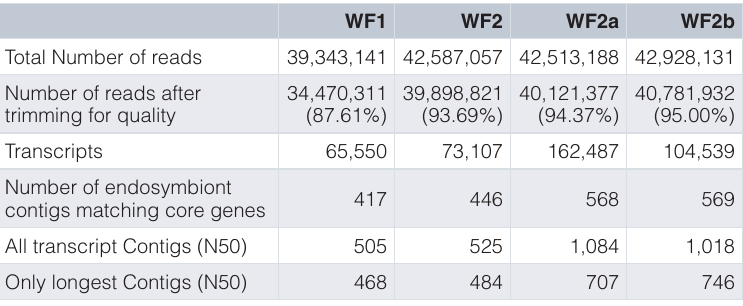
Table 1. Summary statistics from De novo Trinity assemble of Illumina paired end individual whitefly transcriptomes.